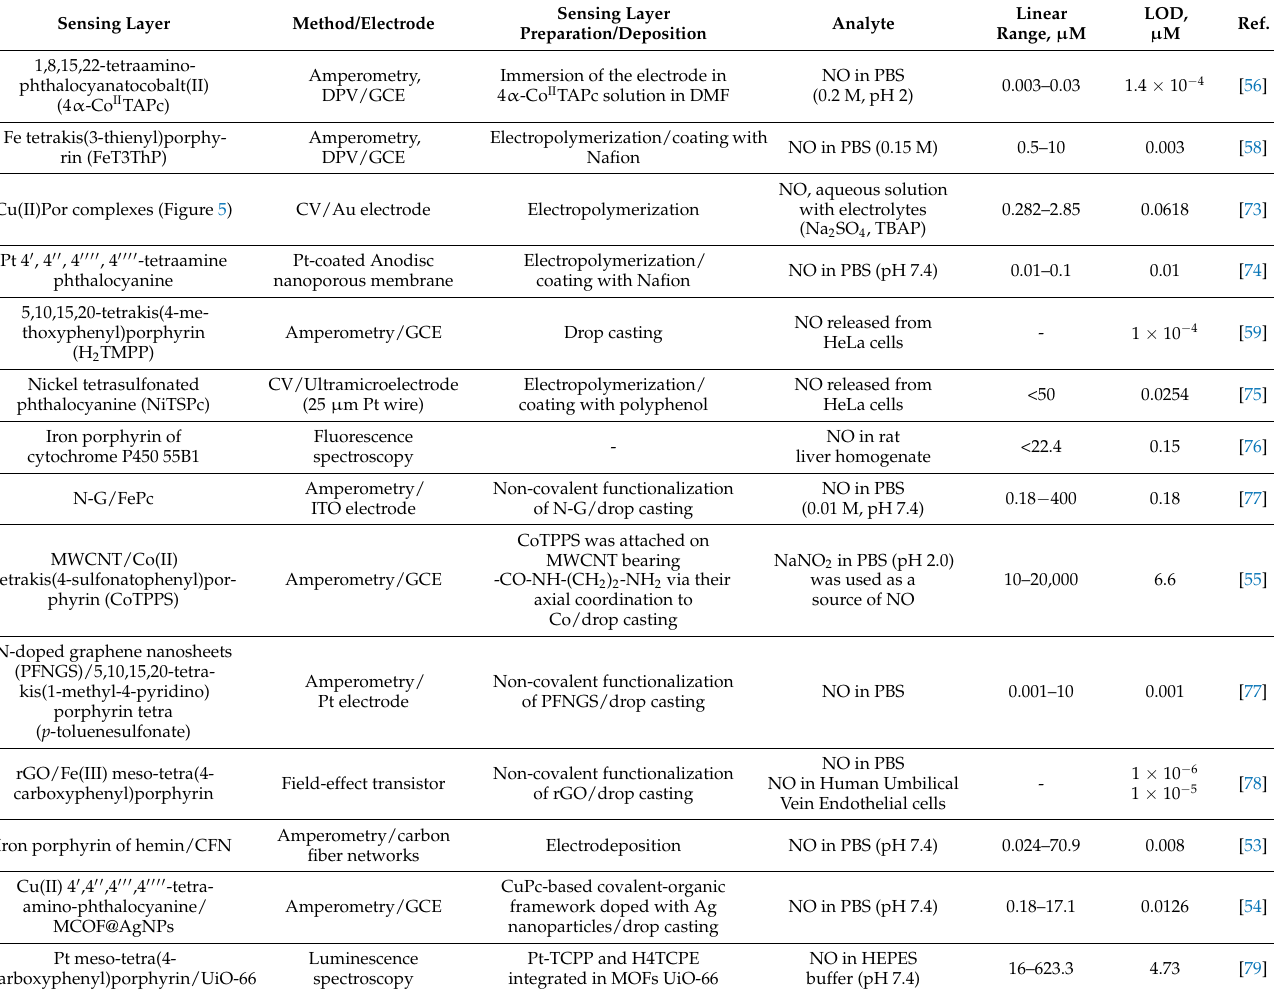
Table 1. Examples of phthalocyanine and porphyrin-based sensors used for the detection of NO in aqueous solutions and biological